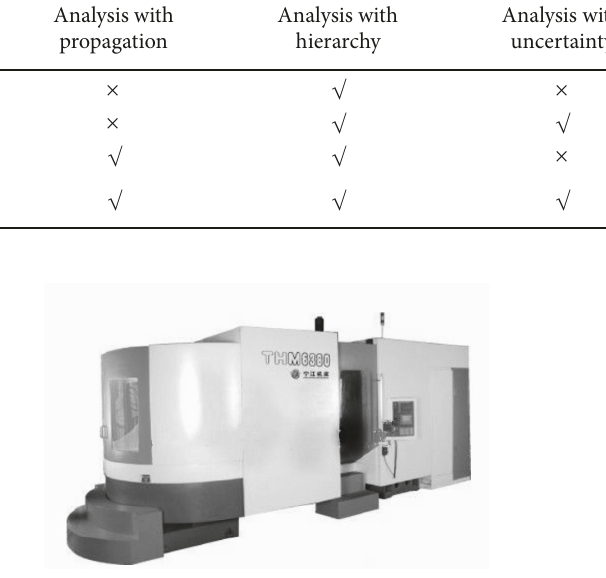
Figure 4: THM6380 machining center.